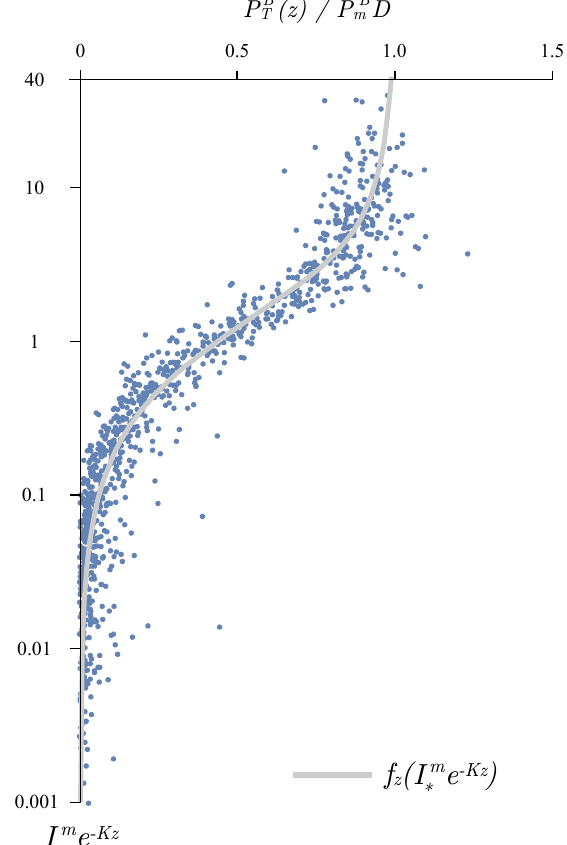
Figure 2. Comparison of the model versus measured production at depth obtained by combining the measured data with the estimated parameter values. The abscissa corresponds to the ratio of ( z ) to the maximum possible production, P B daily production at depth P B m D . The ordinate gives the T dimensionless irradiance, I m ∗ e − Kz . The continuous curve is recognized as the f z ( I m ∗ e − Kz ) function. B (cid:101) I m ( z n ) / P B e − (cid:101) Kz n / P B m ) , where α B and P B m are the estimated The coordinates of each point are ( (cid:101) P B m D , α T 0 parameters for each profile. The r 2 value between the measured normalized production and the modeled normalized production is 0.95. In total, there are 1049